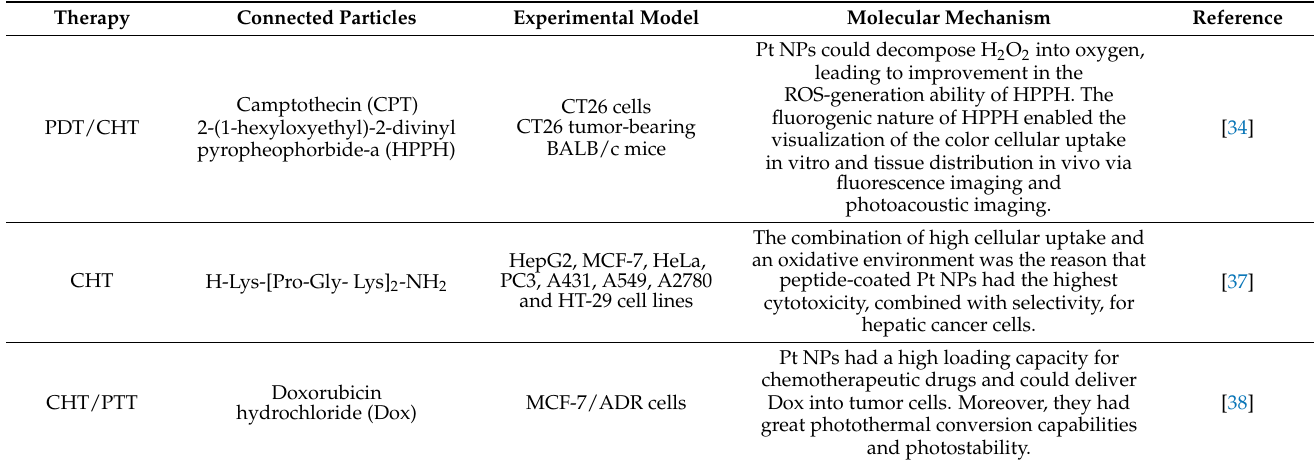
Table 3. Selected connections of biologically active molecules with platinum